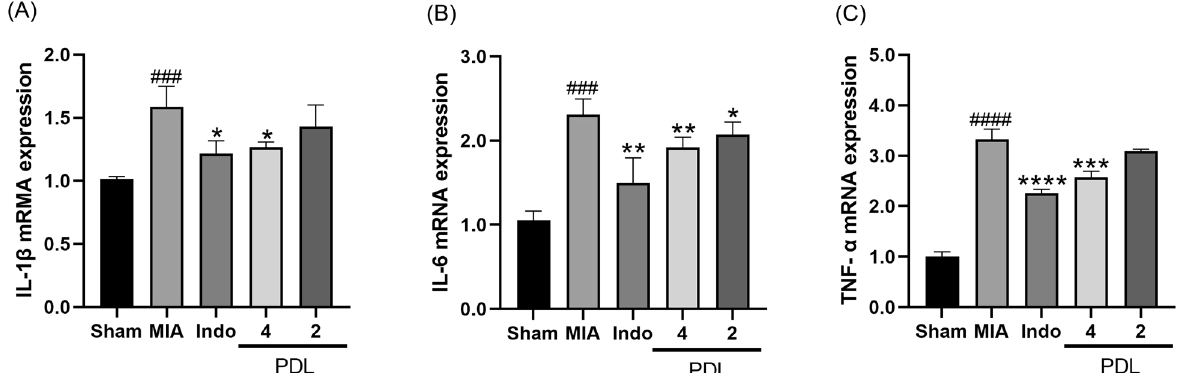
Figure 5. The effect of PDL on mRNA levels of IL-1 ( A ), IL-6 ( B ), and TNF- ( C ) in tibiofemoral joint in MIA- induced OA mice. Data were presented as mean ± SD. (n = 5, ### p < 0.005, #### p < 0.0001, compared with the Sham group. *p < 0.05, **p < 0.01, ****p < 0.0001, compared with the MIA